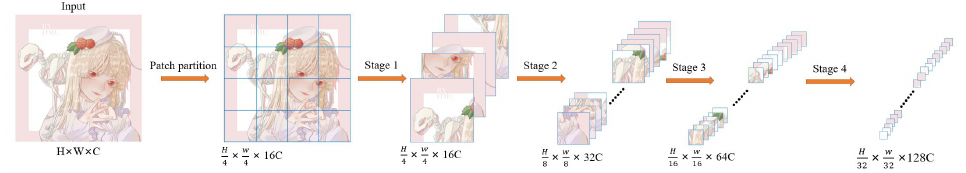
Figure 10. Architecture of a Swin